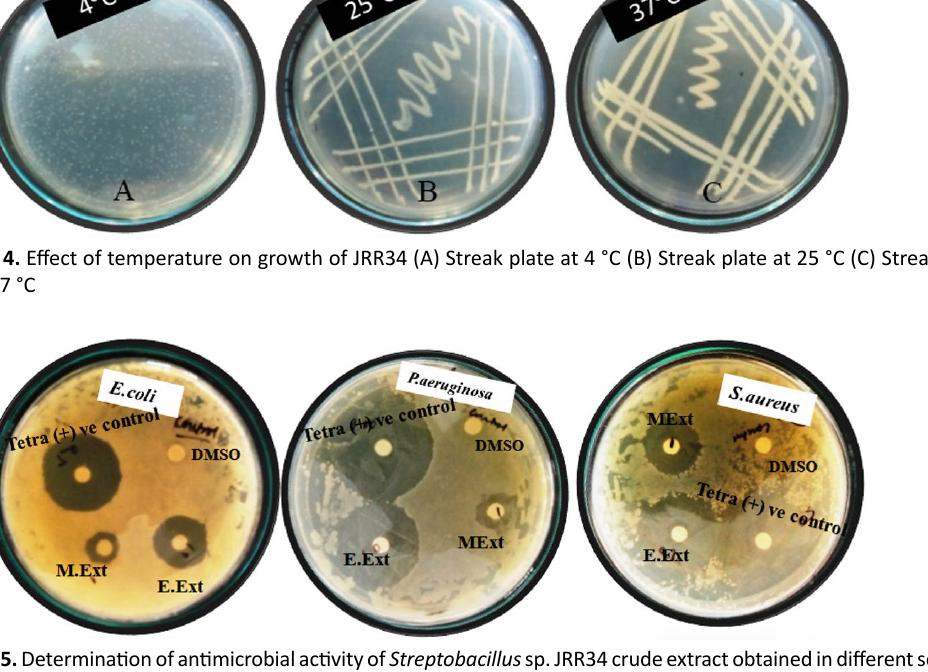
Fig. 5. Determination of antimicrobial activity of Streptobacillus sp. JRR34 crude extract obtained in different solvents against E. coli, P. aeruginosa and S. aureus by disc diffusion